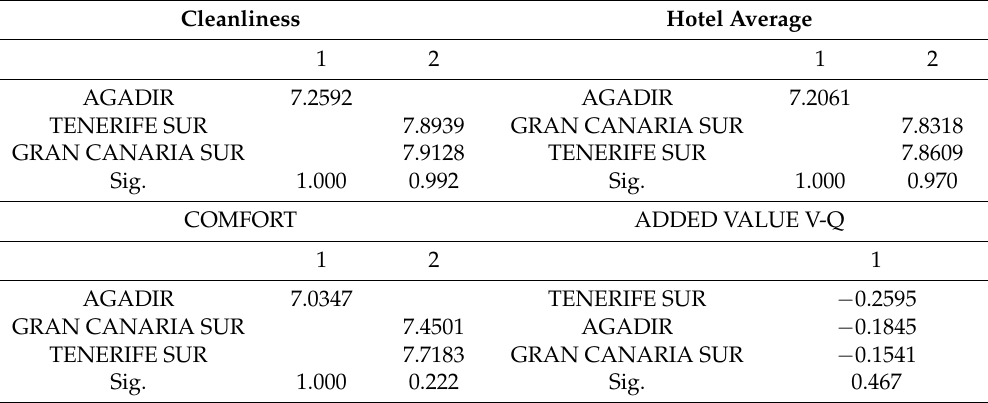
Table 11. The Scheffe test of the tourism destinations.